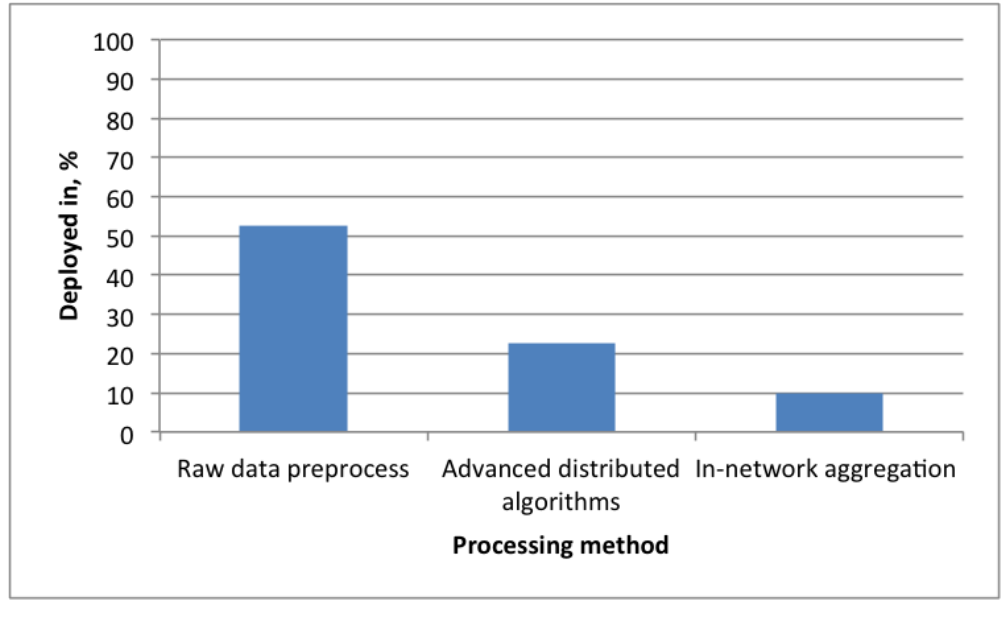
Figure 8. Deployment in-network processing —Raw data preprocessing is used in half of deployments; distributed algorithms and aggregation are seldom used.